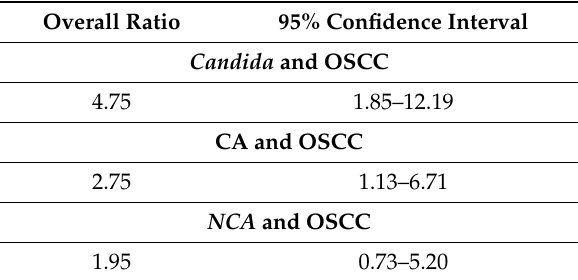
Table 4. Random e ff ect model-based assessment of overall ratio and 95% confidence intervals for Candida prevalence and species specificity from the studies included in the